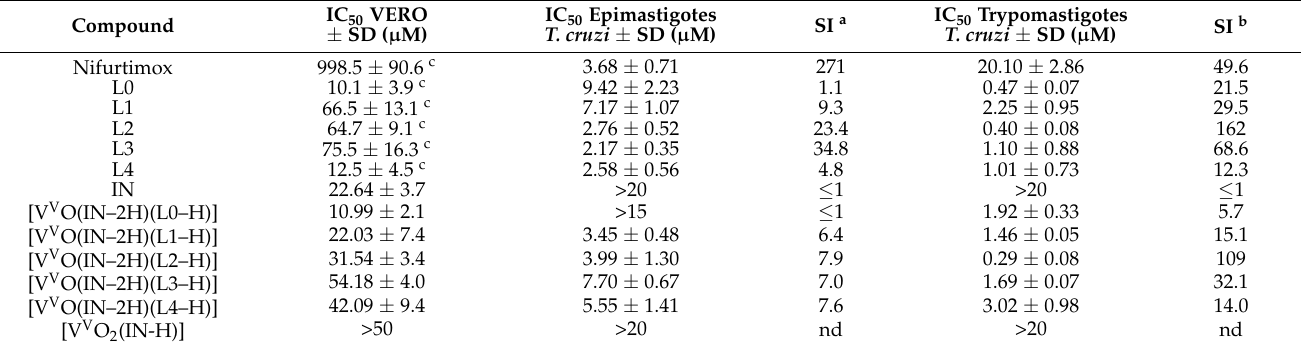
Table 1. In vitro activity on T. cruzi (epimastigotes and trypomastigotes of CL Brener strain), cytotoxicity on mammalian cells (VERO cells) and selectivity towards the parasite (SI value).